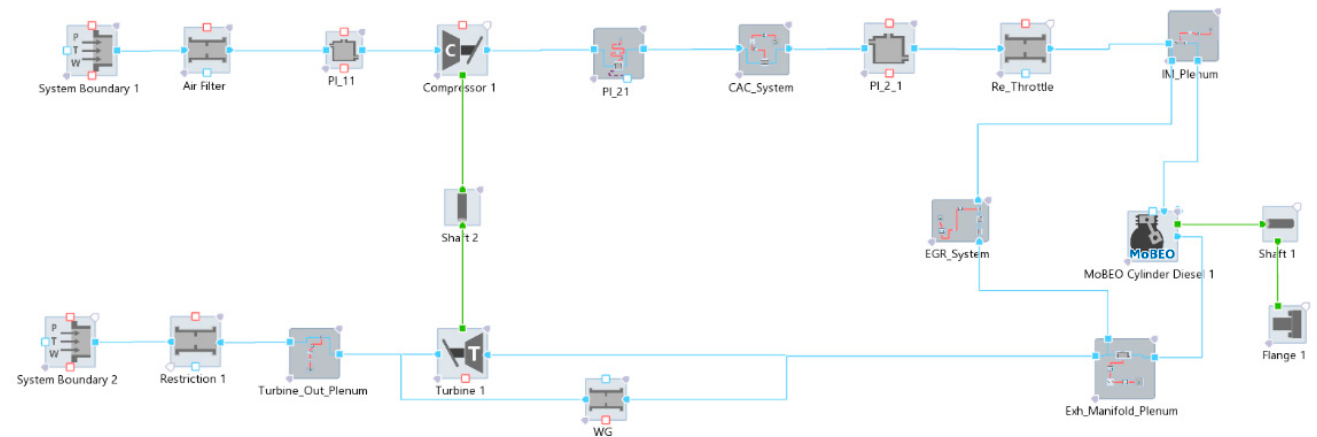
Figure 4. Engine Model sketch in AVL CRUISE™ M environment.